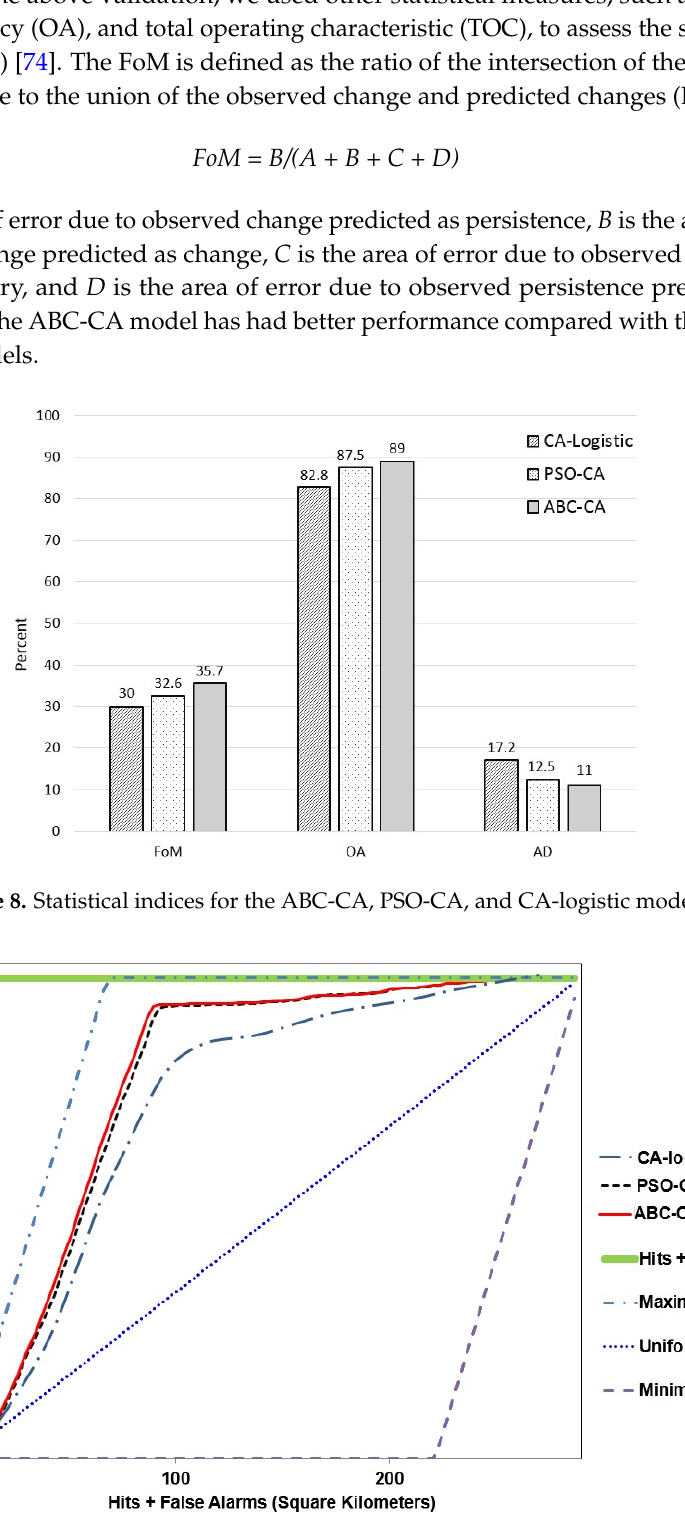
Figure 9. The total operating characteristics (TOC) plot of the ABC-CA, PSO-CA, and CA-logistic models.